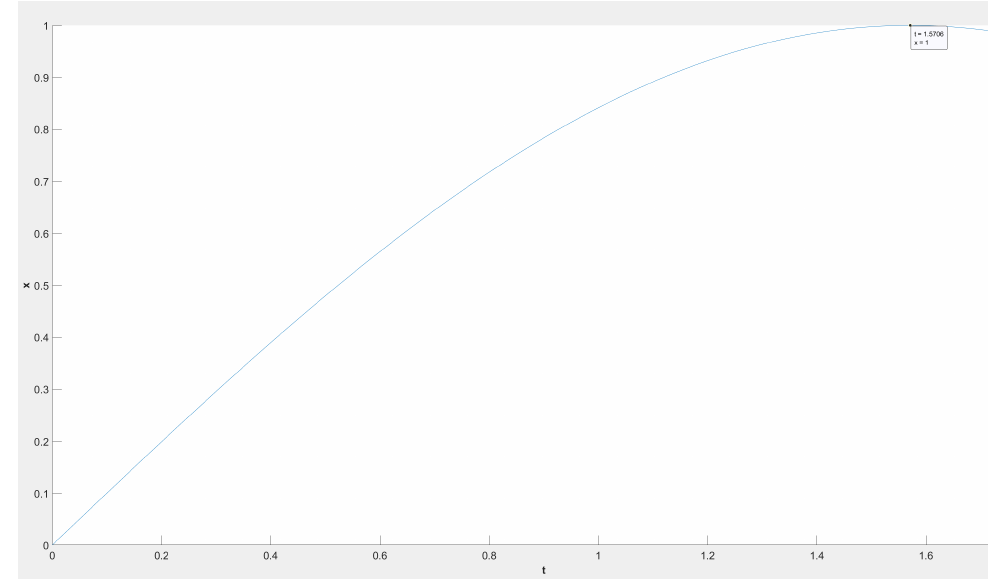
Figure 2. Solution without impulses of the derivative of x ( t )